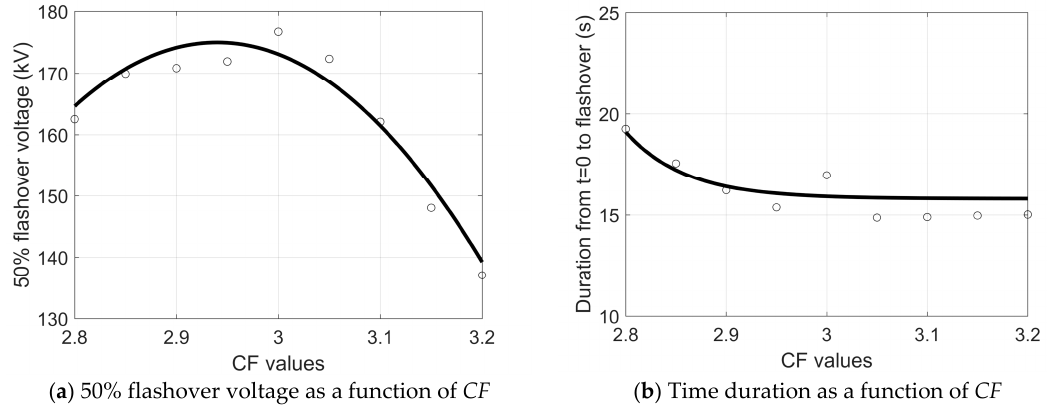
Figure 14. 50% flashover voltage and time duration as functions of the CF value.